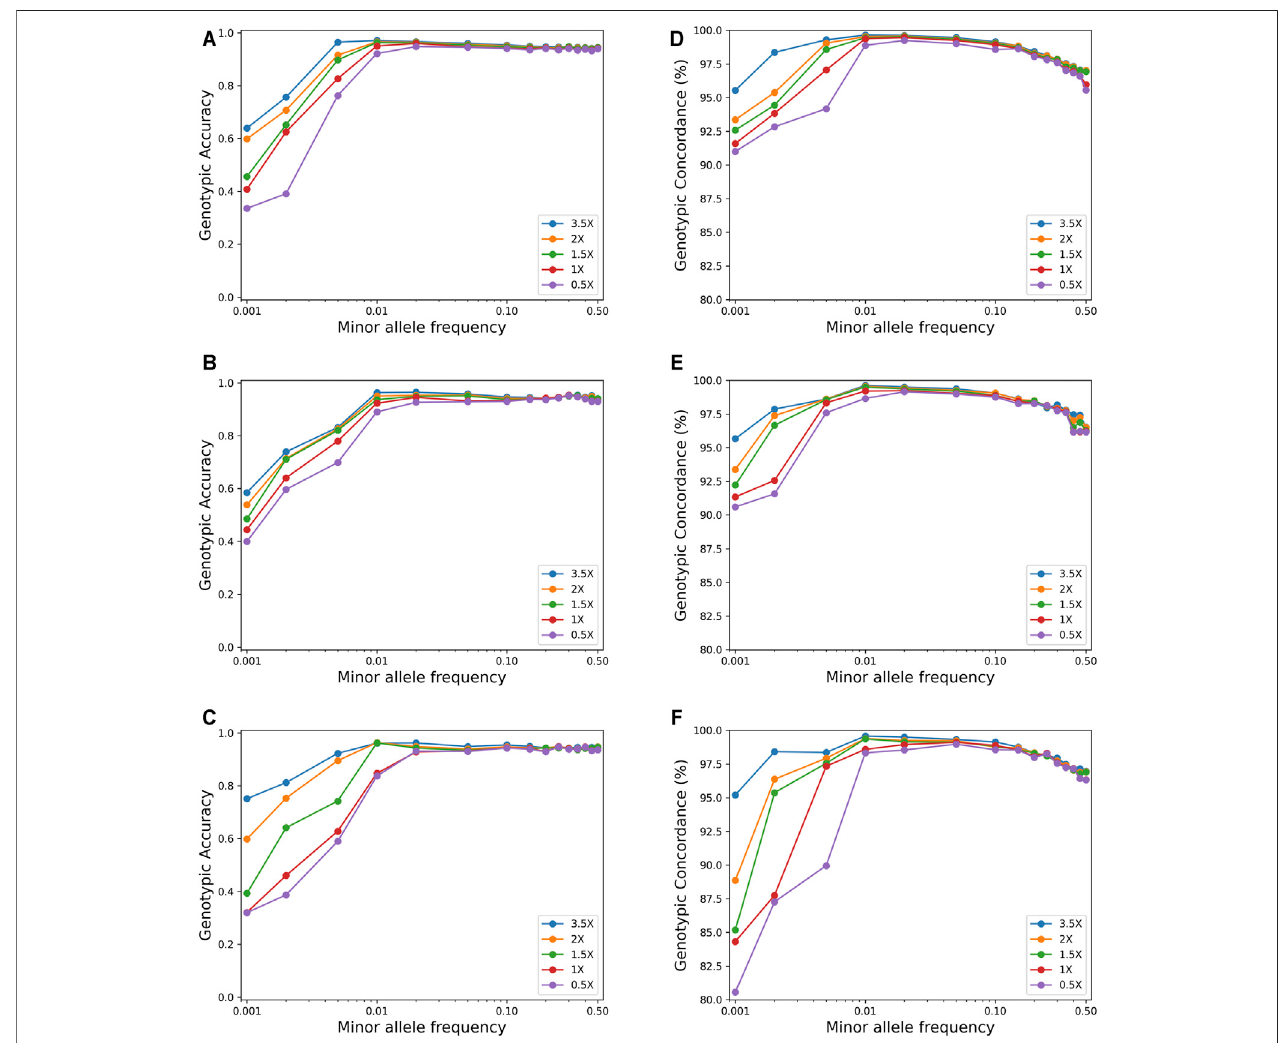
FIGURE 3 | Effects of minor allele frequency on imputation genotype accuracy and genotype concordance using the pipeline of BaseVar + STITCH (sample size (cid:1) 617). (A – C) represent genotype accuracy for chromosomes 1, 19, and 30, respectively; (D – F) represent genotype concordance for chromosomes 1, 19, and 30,